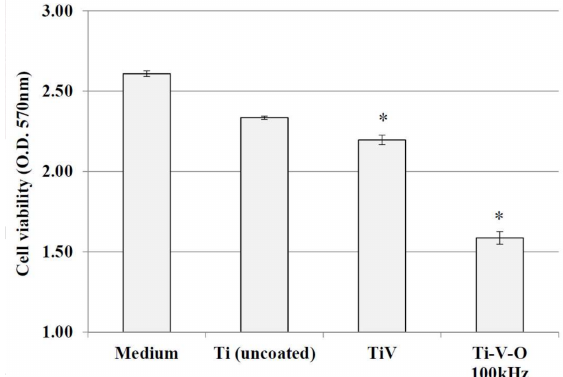
Figure 13. Cell viability of the extraction medium, Ti (uncoated) sample, TiV coating, and 100 kHz LSTO Ti-V-O coating. * Significantly different from the control group—uncoated Ti plate ( p < 0.01).